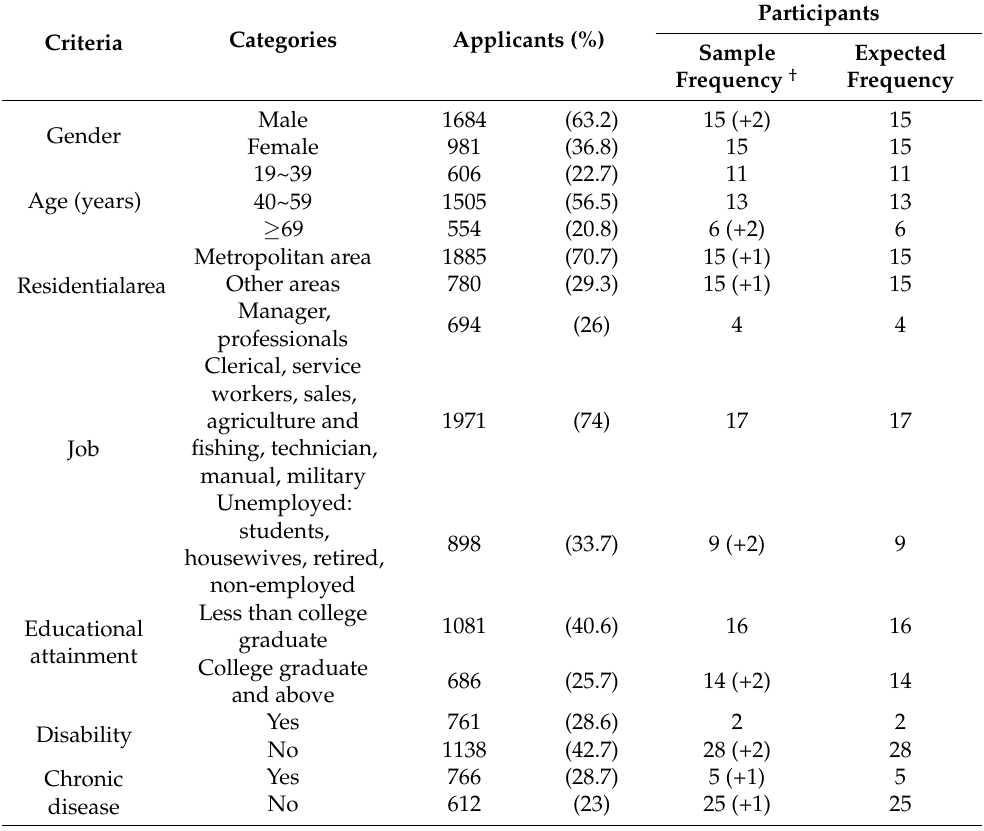
Table 1. Description of Citizens’ Jury and comparison with the Korean